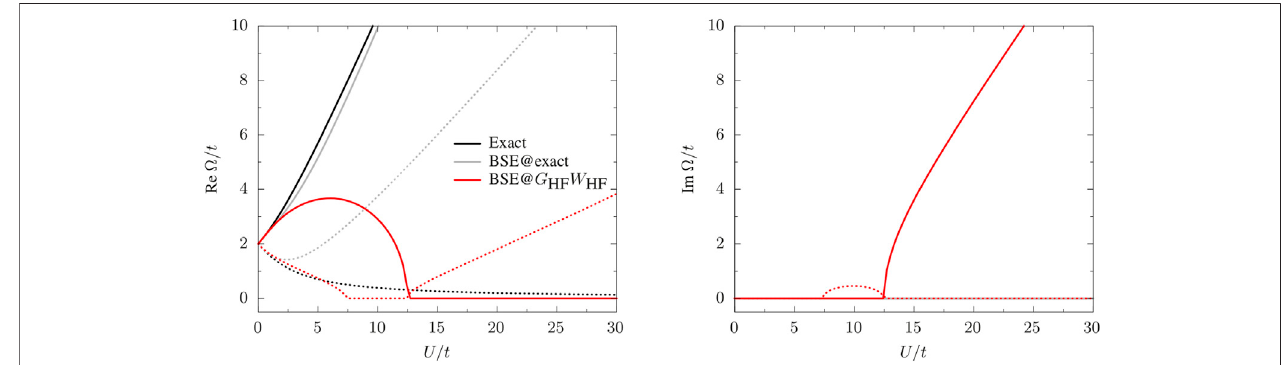
FIGURE 3 | Real and imaginary parts of the singlet (solid) and triplet (dotted) neutral excitations, Ω ↑↓ 1 and Ω ↑↑ 1 , as functions of U / t : exact (black), BSE with exact quasiparticle energies and W HF (gray), BSE@ G HF W HF